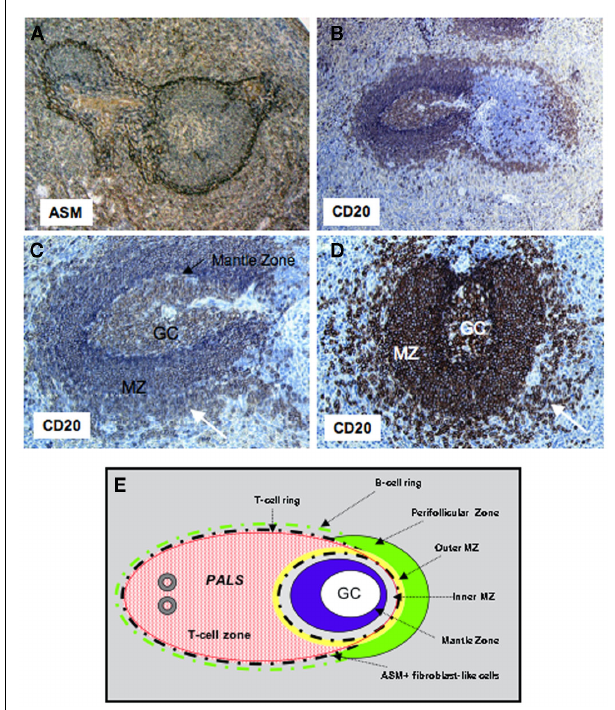
FIGURE 1 | Organization of the follicular and MZ B-cell compartments in human. Sections of human spleens were stained with mAbs to CD20 or alpha smooth muscle actin (ASM). (A) The network of fibroblast-like cells stained by the anti-ASM mAb subdivides the outer and inner MZ around the follicles, and separates theT-cell zone from the red pulp. Original magnification × 10. (B) A ring of B-cells can be seen outside the ASM + network in both theT and B-cell zones. Original magnification × 10. (C,D) Secondary B-cell follicles with a central germinal center, the mantle zone (intense blue in C, black arrow), the MZ, and the perifollicular zone (white arrow) with less dense accumulation of B-cells. Original magnification × 20. (E) Schematic representation of theT- and B-cell zones in human spleen. GC, germinal center; PALS, periarteriolar lymphatic sheath; MZ, marginal